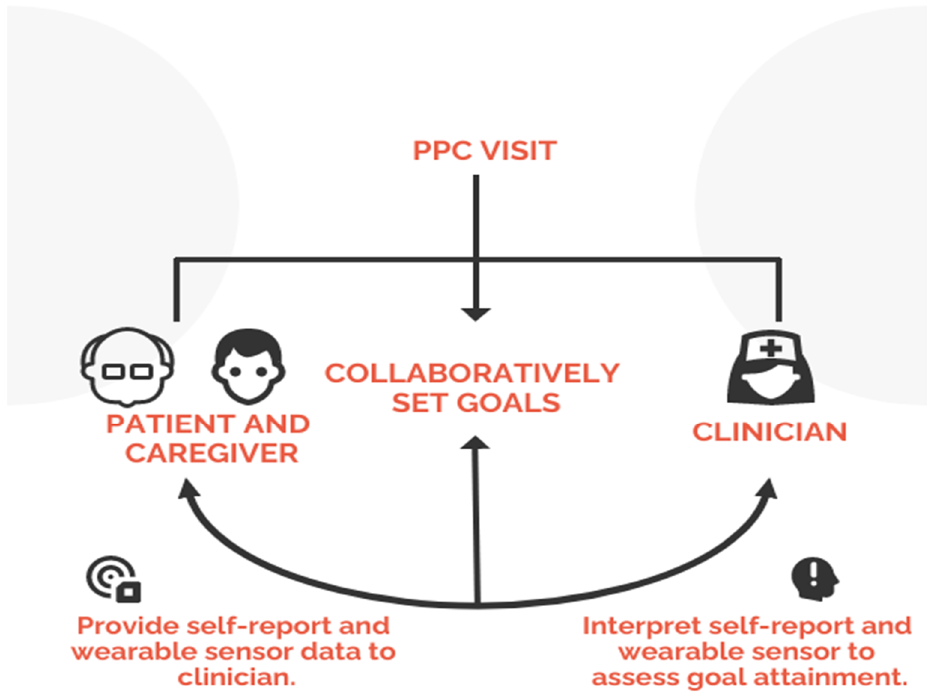
Figure 2. Patient Priorities Care program to determine patient-centric health priorities and setting relevant goals. Wearable sensors were used to determine patient participation in achieving the goals and facilitate the goal-setting process.